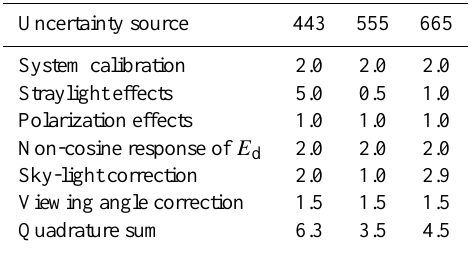
Table 8. Uncertainty budget (in percent) for R rs determined from TRIOS-E